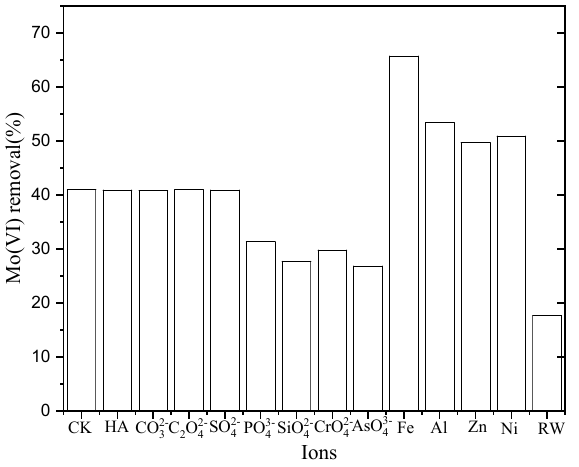
Figure 4. Impact of coexisting ions on Mo(VI) removal by NZVI/AC at 8.1. Initial Mo(VI) concentration was 0.1603 mg/L and 0.1603 mg/L; the molar ratio of Mo to coexisting anions was 1:10; humic acid (HA) added was 5 mg/L.